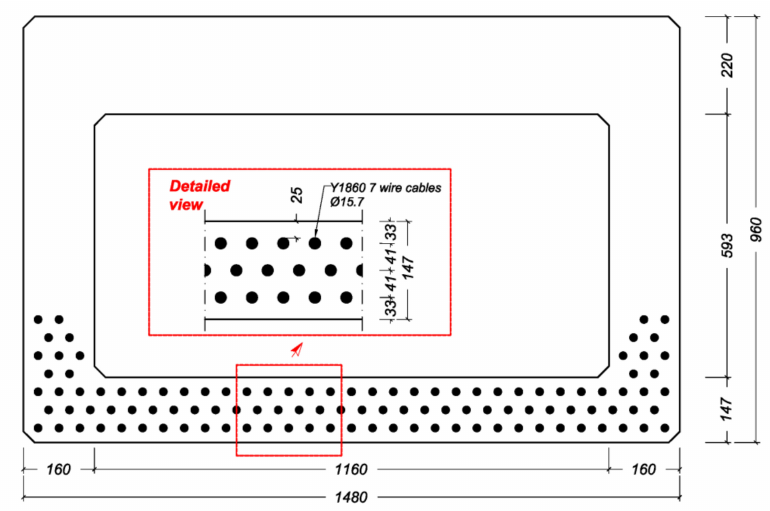
Figure 13. Designed cross-section of the girder with the distribution of the prestressing strands for the level 3 analysis (Figure 12).